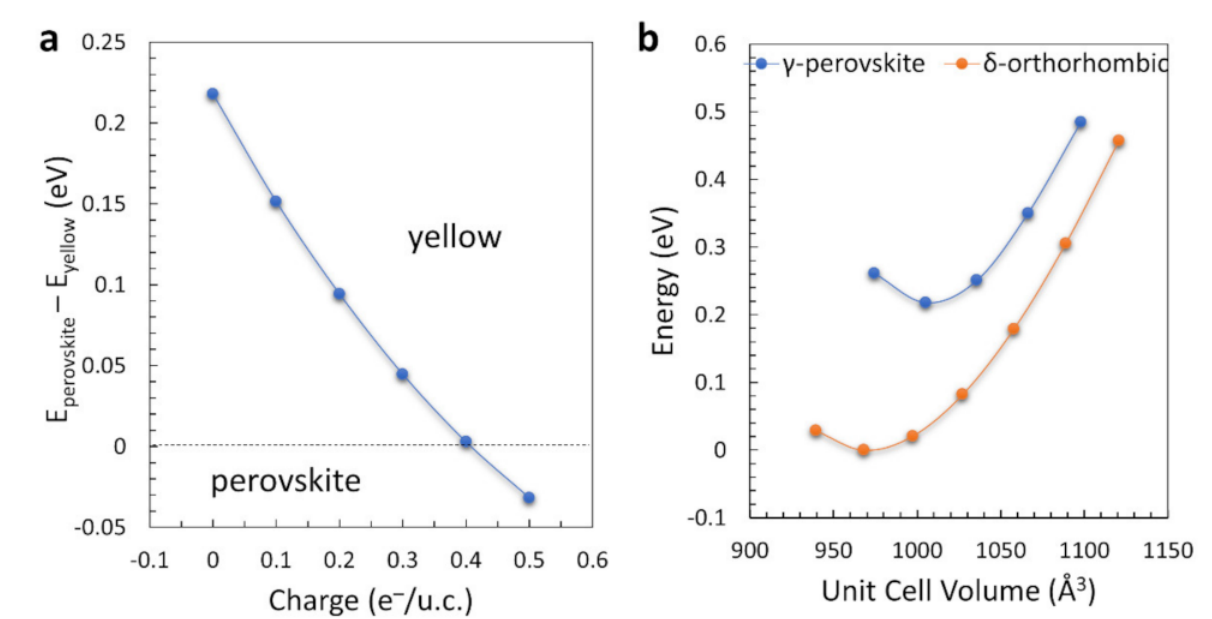
Figure 5. ( a ) Difference in the calculated ground-state energy per unit cell between the γ and the δ phases of CsPbI 3 as a function of electron doping; ( b ) Relative ground-state energies of γ -CsPbI 3 and δ -CsPbI 3 upon volume expansion and contraction. The reference energy at 0 eV has been set to the minimum energy of the δ